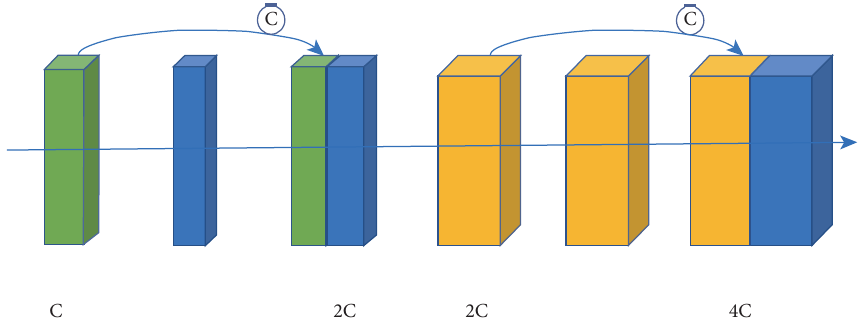
Figure 5: Cross-layer